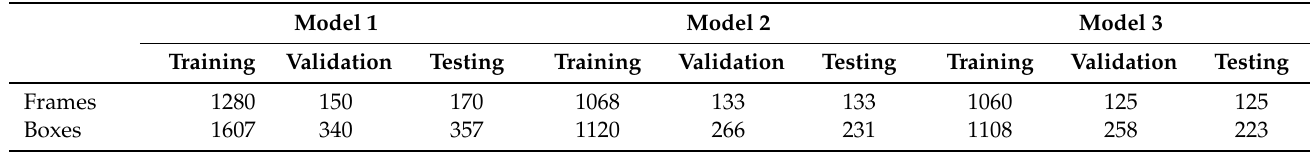
Table 2. Klim dataset. Training, validation, and test splits for models 1, 2 and 3. Both validation and testing comprise 10% each of the total dataset.